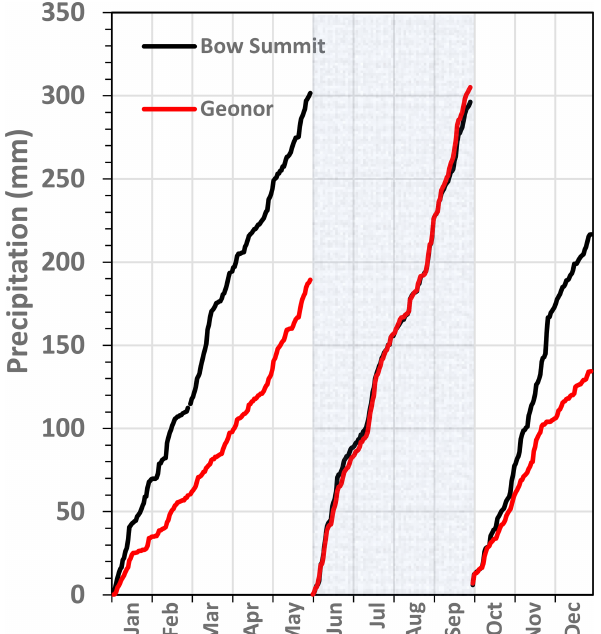
Figure 9. Seasonal Bow Summit and Peyto Main cumulative pre- cipitation from 7-year averages of daily values, 2010 to 2016 inclu- sive, with main summer rainfall months shaded.